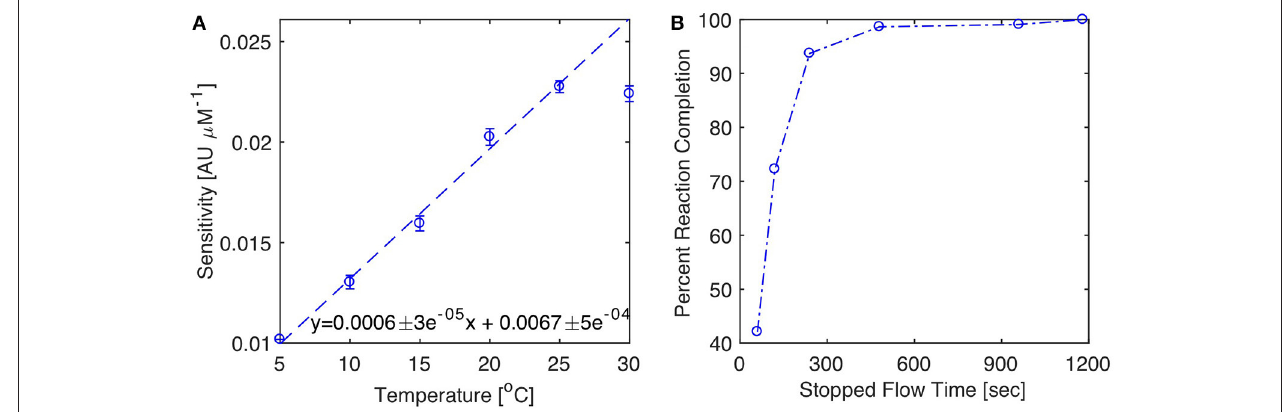
FIGURE 4 | Impact of temperature and reaction time on analytical sensitivity. (A) Analytical sensitivity vs. incubation temperature. Analytical sensitivity defined as slope ± 1 S.E of calibration curves ran at each temperature with a 300s reaction time. The inset equation is the linear regression between temperature and sensitivity from 5 to 25 ◦ C (dashed line). (B) Percent reaction completion at 20 ◦ C as a function of length of stopped flow period. The percent reaction completion is defined as the slope of calibration curves obtained at each stopped-flow time (60, 120, 240, 480, 960, 1,180s) normalized by the slope of the calibration at 1,180s. This assumes that the reaction is complete after a reaction time of 1,180s.